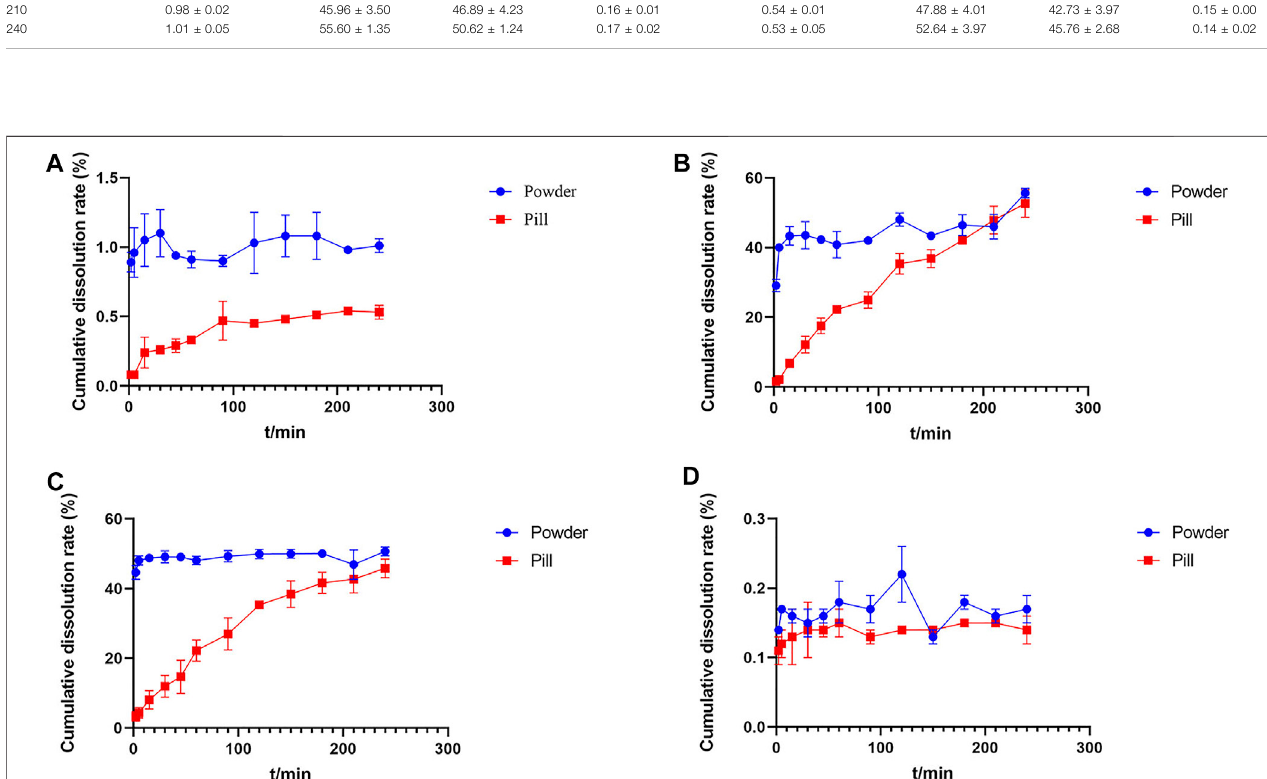
Frontiers in Pharmacology |